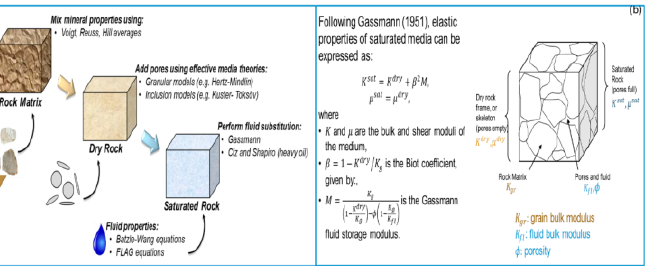
Figure 1. ( a ) Physics model for carbonate rocks after [25], and ( b ) fluid substitution saturated Properties after [24].